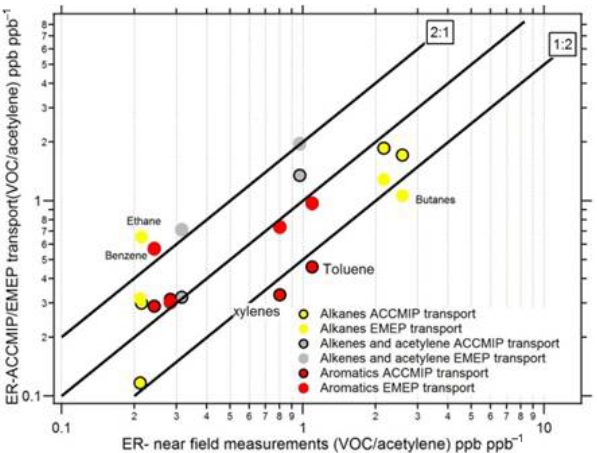
Figure 10. Comparison of the emission ratios relative to acetylene from the ACCMIP and EMEP emission inventories for road trans- port and the ER from road transport using near-field